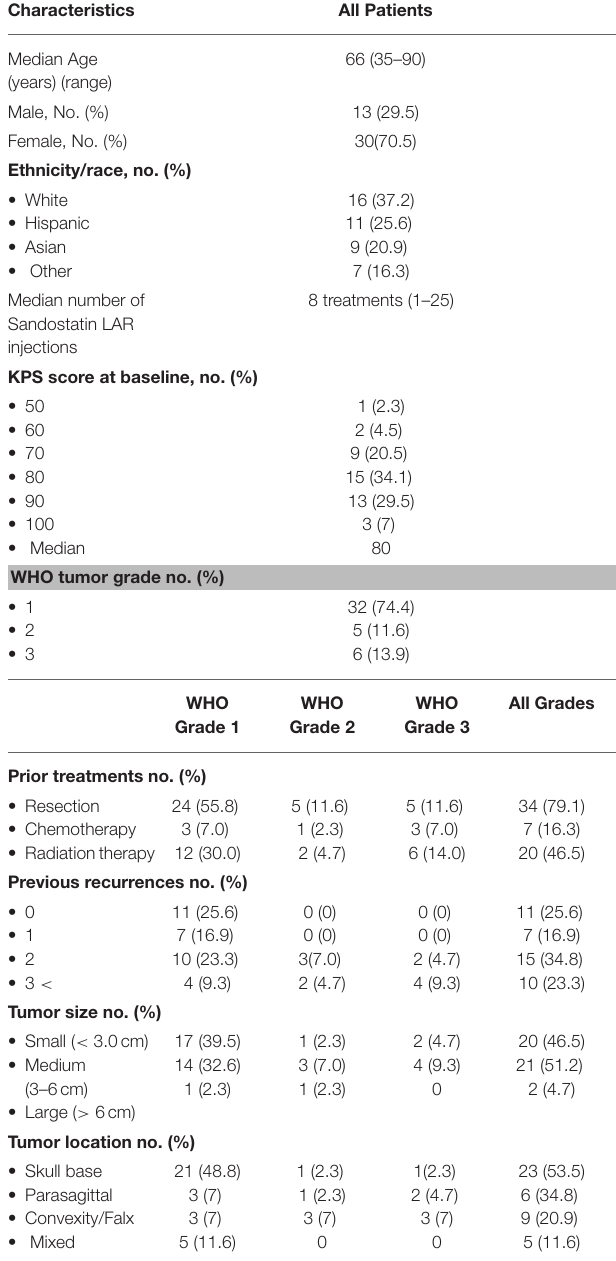
TABLE 1 | Patient demographic and clinical characteristics ( n =